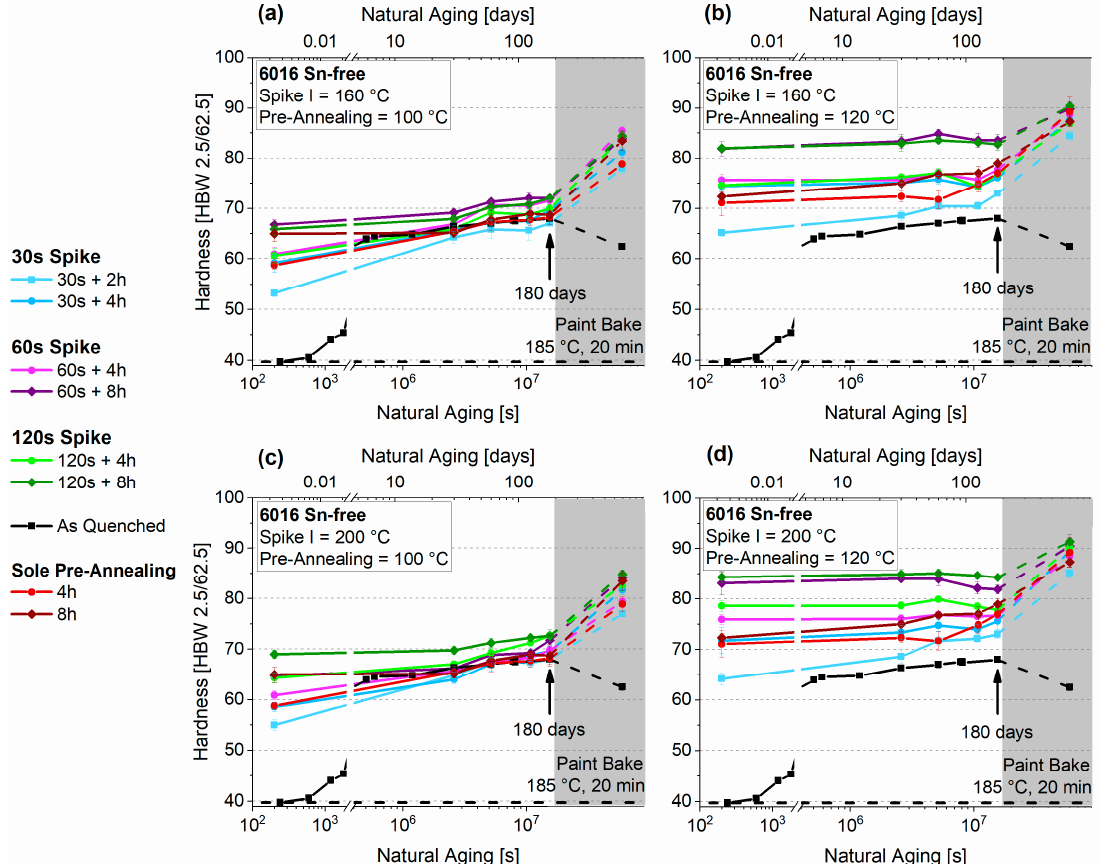
Figure 6. Natural aging behavior of samples treated according to PA2 for EN-AW-6016 Sn-free. Spike I 160 °C + PA 100 °C, ( a ) Spike I 160 °C + PA 120 °C, ( b ) Spike I 200 °C + PA 100 °C, ( c ) Spike I 200 °C